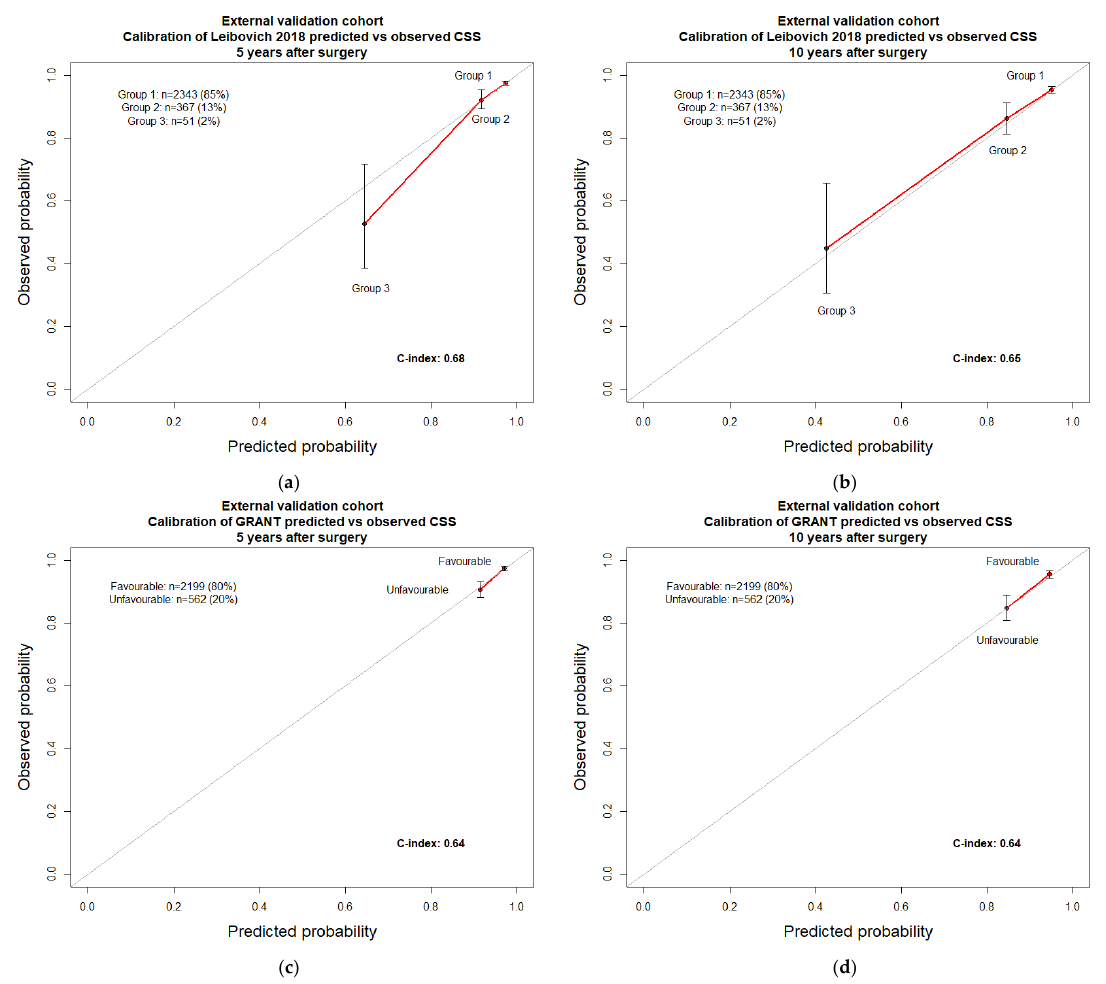
Figure 3. External validation cohort: Leibovich 2018 and GRANT prognostic models calibration plots. CSS: cancer - specific survival. ( a ) Cancer - specific survival at five years according to Leibovich 2018; ( b ) cancer - specific survival at ten years according to Leibovich 2018; ( c ) cancer - specific survival at five years according to GRANT; ( d ) cancer - specific survival at ten years according to GRANT.